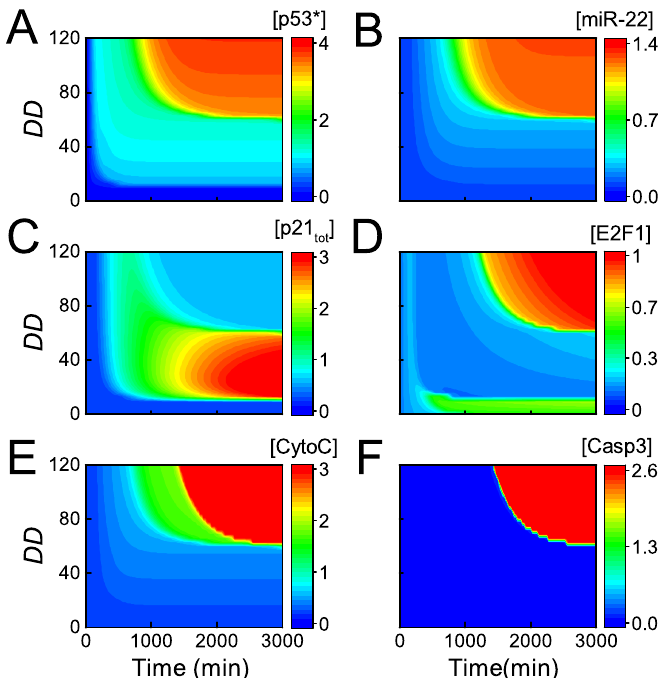
Figure 6. Dynamics of the key network components for varying intensities of DNA damage. The heatmap of [p53 ∗ ] ( A ); [miR-22] ( B ); [p21 tot ] ( C ); [E2F1] ( D ); [CytoC] ( E ); and [Casp3] ( F ) as a function of Time and DD